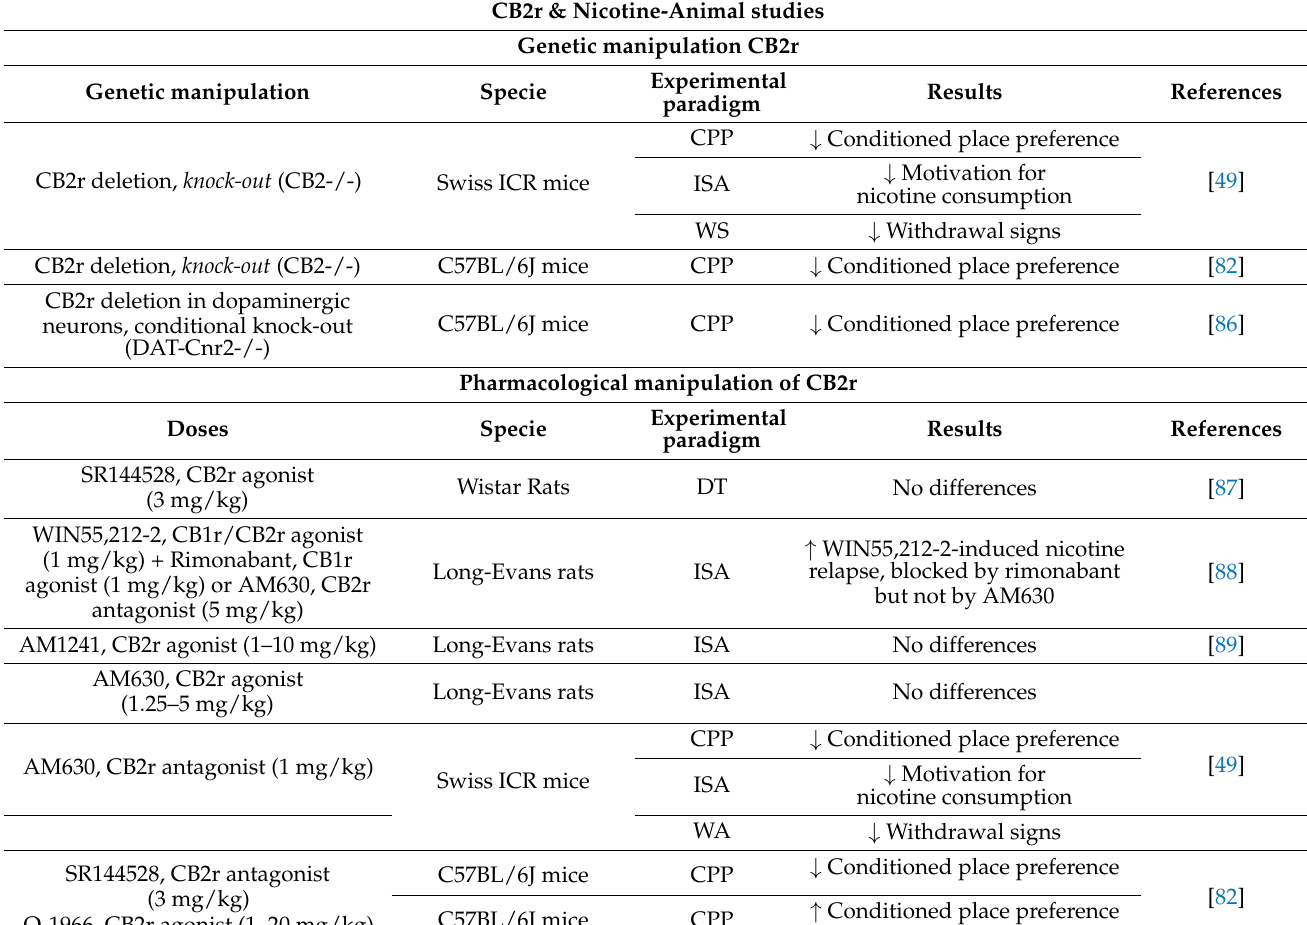
Table 3. Main findings supporting the involvement of CB2r in the regulation of the reinforcing and motivational effects of nicotine. CB2r & Nicotine-Animal studies Genetic manipulation CB2r Experimental Genetic manipulation Specie paradigm